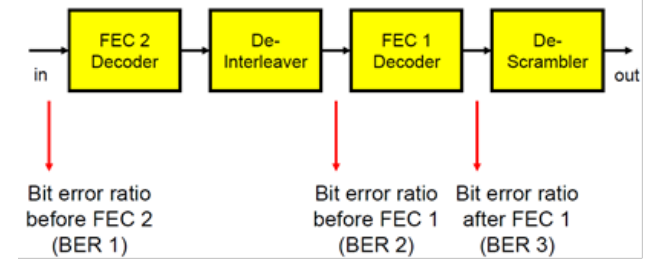
Figure 12. Anticipatory error correction in the receiver.